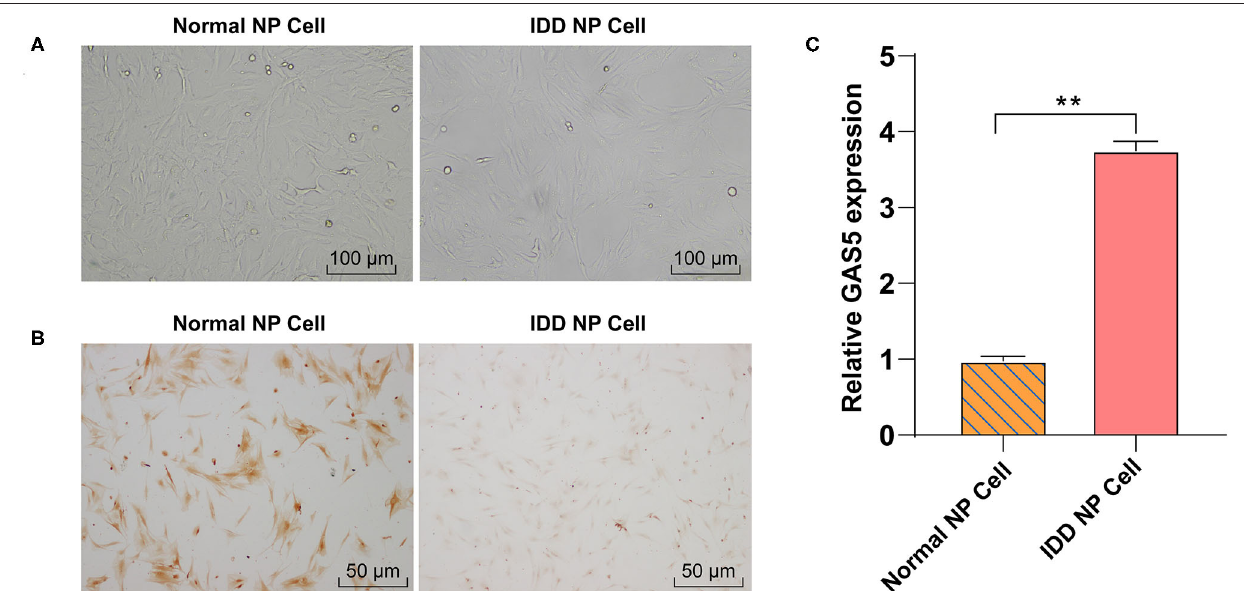
FIGURE 1 | LncRNA GAS5 is upregulated in degenerative NPCs. (A) The morphology of degenerative NPCs and normal NPCs was observed under an inverted phase contrast microscope. (B) The synthesis of Collagen II (Col II) was detected by immunocytochemistry. (C) The expression of GAS5 in degenerative NPCs and normal NPCs was detected by RT-qPCR. The cell experiment was repeated three times, and the data were expressed as mean ± standard deviation; independent t -test was used for comparison between groups. ** p < 0.01; NP, nucleus pulposus.